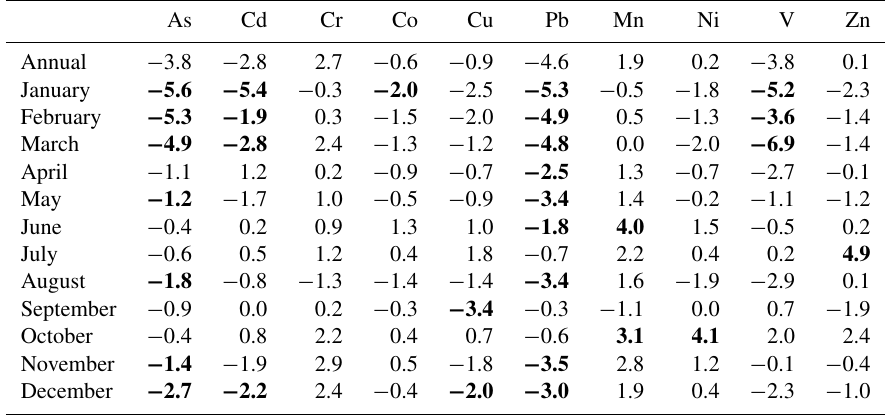
Table 8. Annual trends (%) as calculated from Sen’s slope for annual and (individual) monthly means. Significant trends at the 95% confidence level are given in